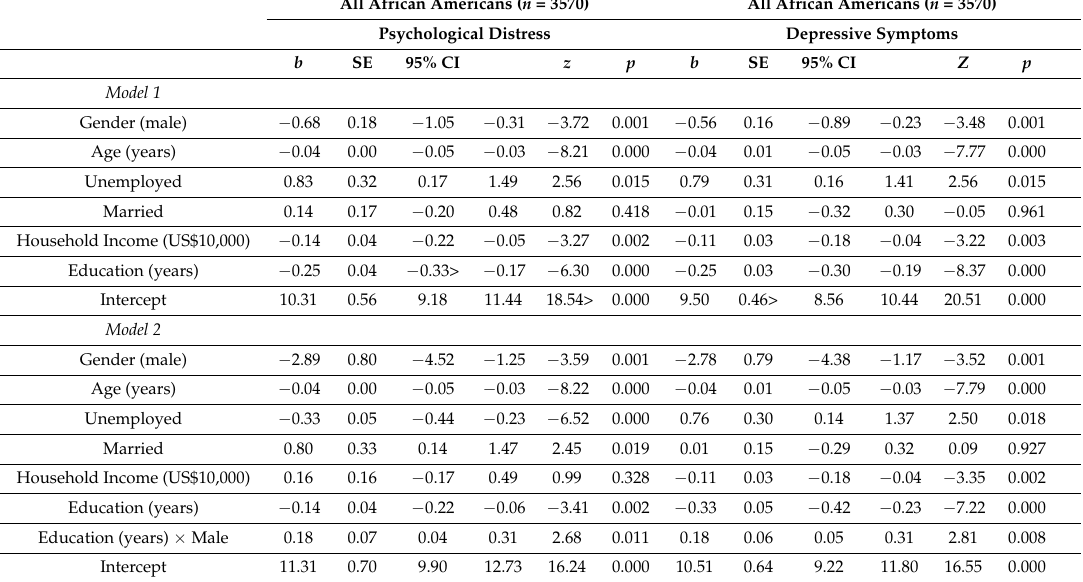
Table 2. Summary of linear regression education attainment on depressive symptoms and psychological distress in the pooled sample of African American